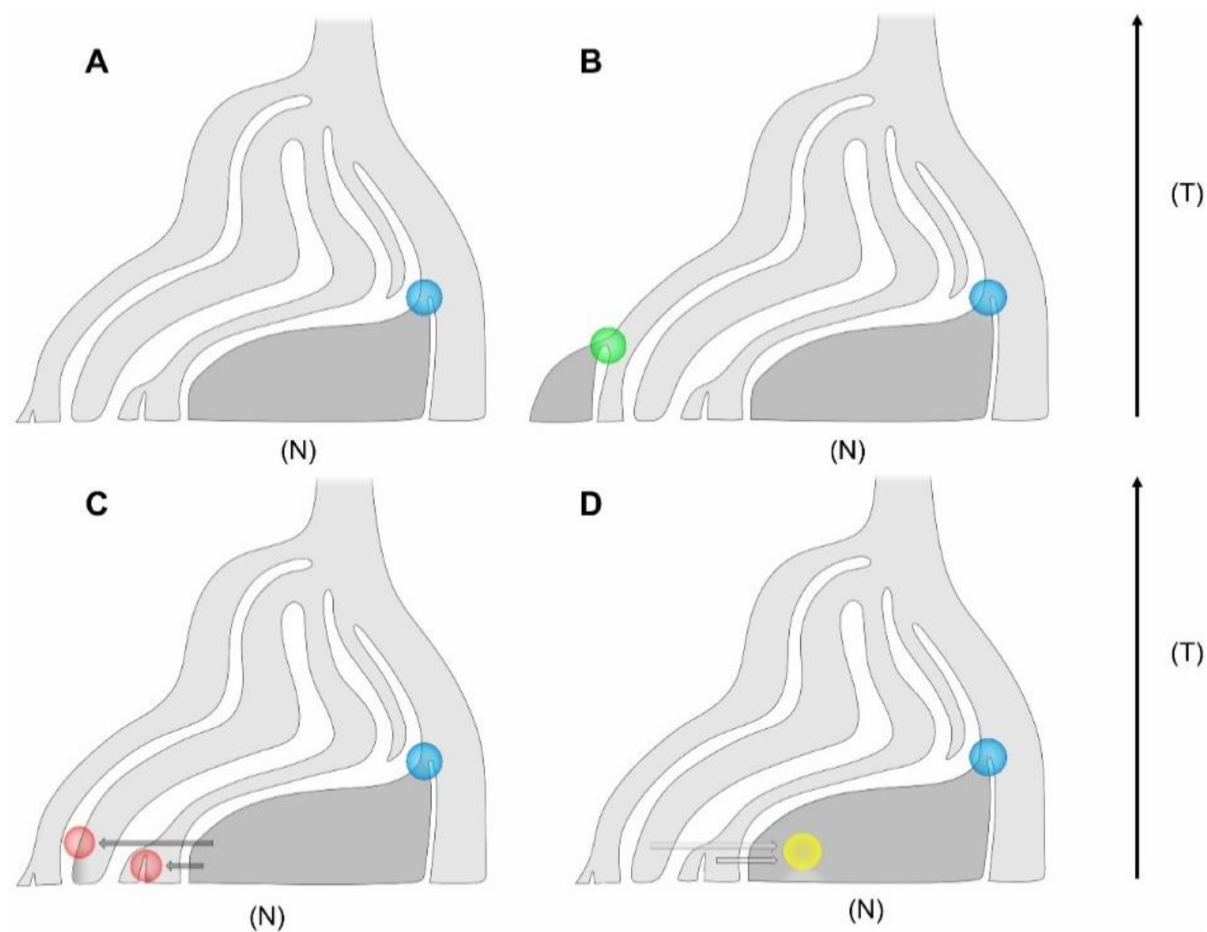
Figure 2. Main models of domestication proposed in the literature to explain the evolution of ancestral wild (light grey) and domesticated grapevine (dark grey). ( A ) Single-origin model; blue circle indicates a demographic bottleneck which occurred during the evolution of grapevine. ( B ) Multi-origin model; green circle indicates a secondary domestication event. ( C ) Multiple events of introgression from domesticated to wild grapevine (red circles) caused by gene flow (dark grey arrows). ( D ) Multiple events of introgression from wild to domesticated grapevine (yellow circle) caused by gene flow (light grey arrows). T = time (arrowhead indicates the past) and N = size of